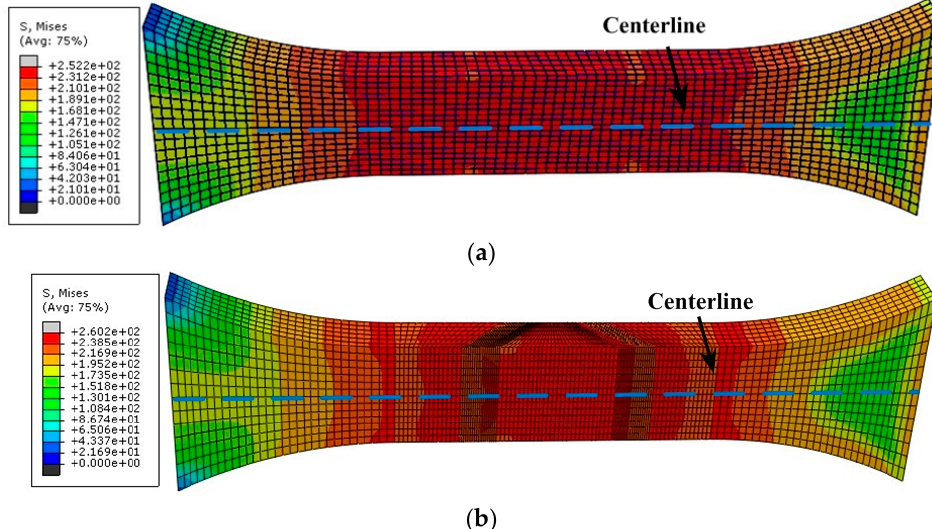
Figure 11. Von Mises stress contour plots of ( a ) continuous joint model and ( b ) partitioned joint model.